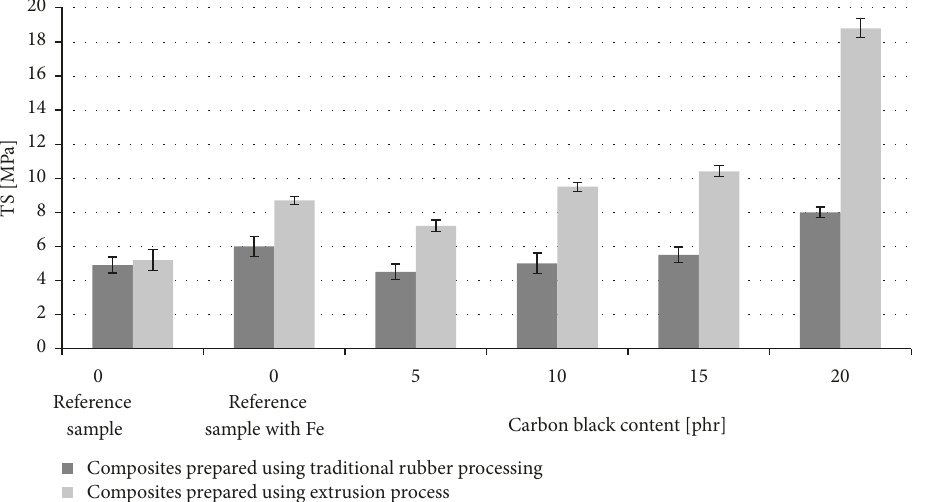
Figure 1: Tensile strength of ethylene-octene composites prepared using extrusion and traditional rubber processing methods. Table 3: Mechanical properties and cross-linking density of magnetorheological composites prepared by different producing methods.